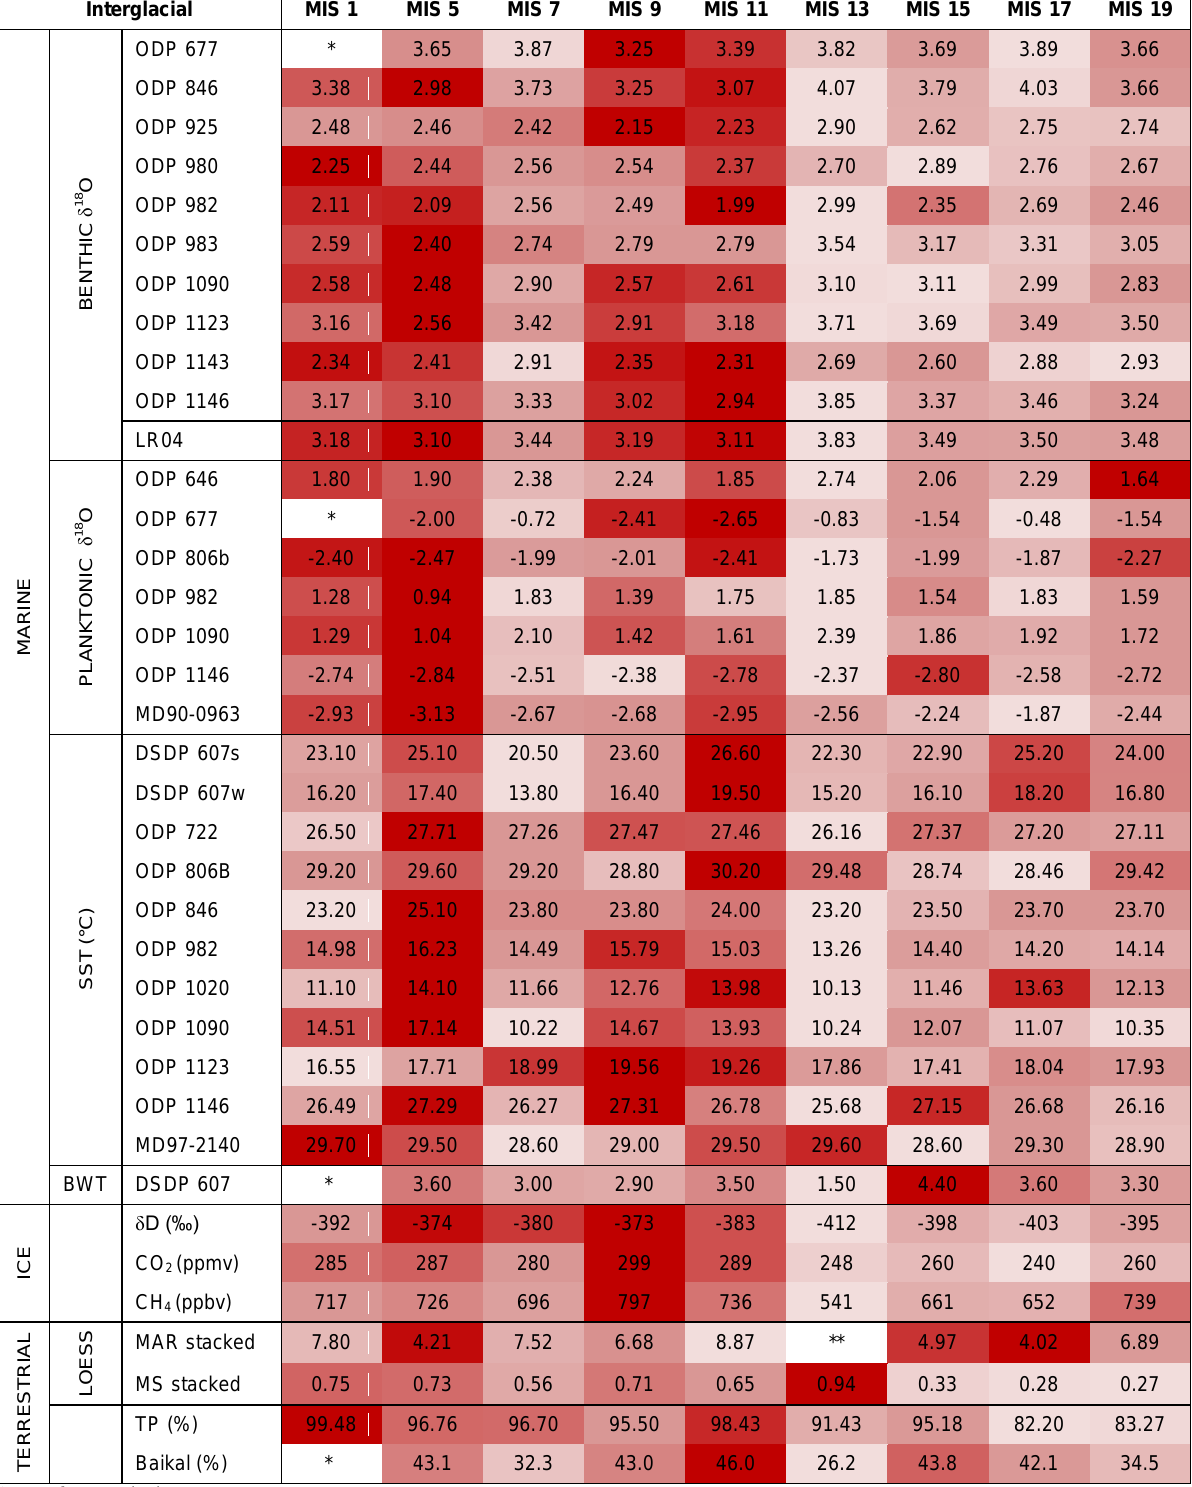
Table 3 - Maximum (post-termination) values for each interglacial. The values are colour-coded according to strength, with deep red being the strongest, and pale red the weakest, interglacial signal for each palaeoclimate record.